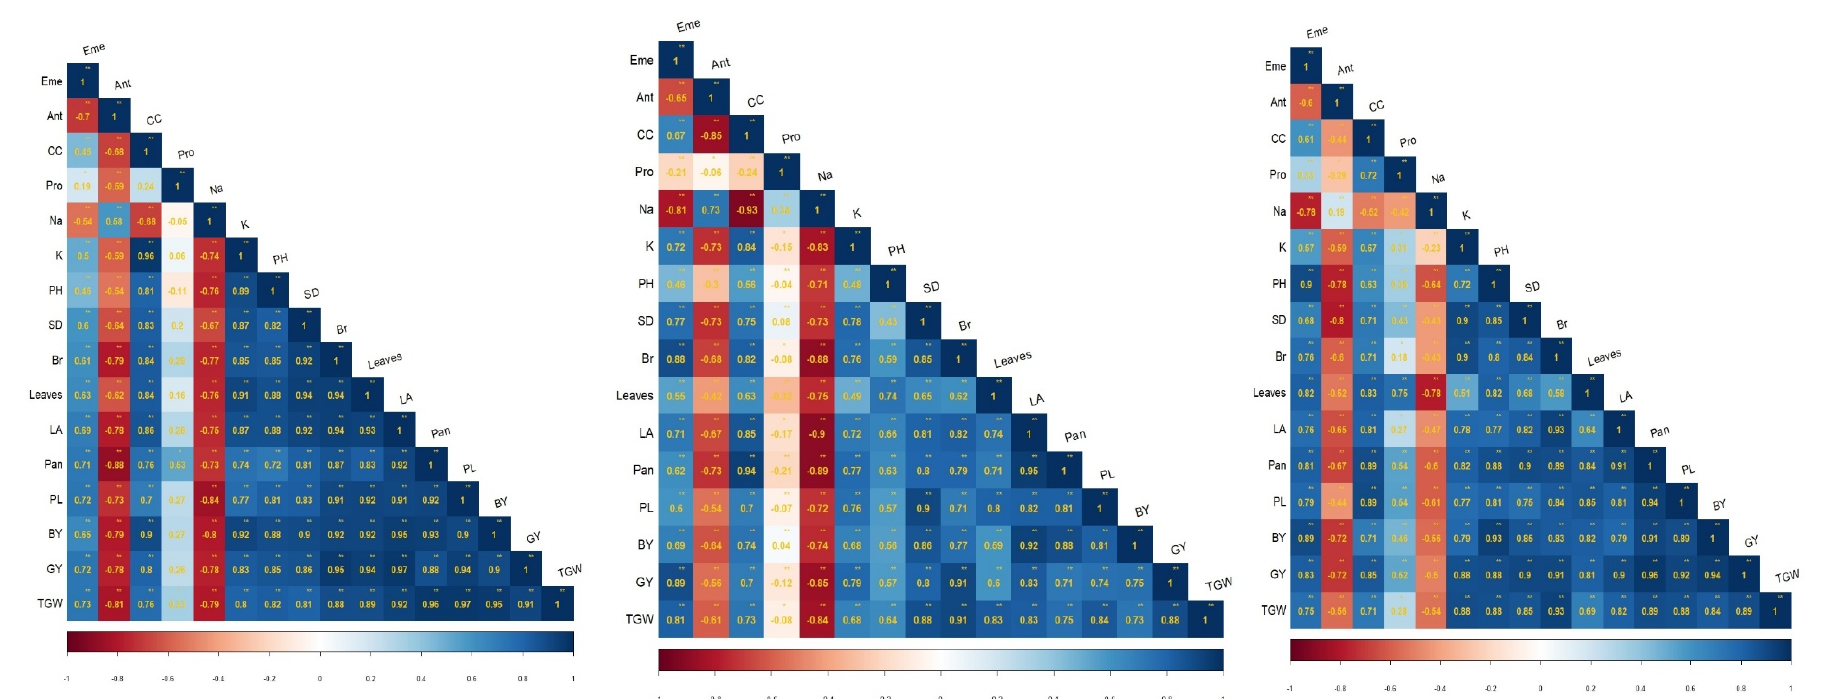
Figure 7. Pearson correlation among various biochemical, growth and yield attributes of ten quinoa lines grown under varying sowing dates. Eme = emergence percentage, Ant = days taken to anthesis, CC = chlorophyll content, Pro = protein, Na = sodium, K = potassium, PH = plant height, SD = stem diameter, Br = number of branches, LA = leaf area, Pan = number of panicles, PL = panicle length, BY = biological yield, GY = grain yield, TGW = thousand grain weight. * = significant at p < 0.05, ** = significant at p <